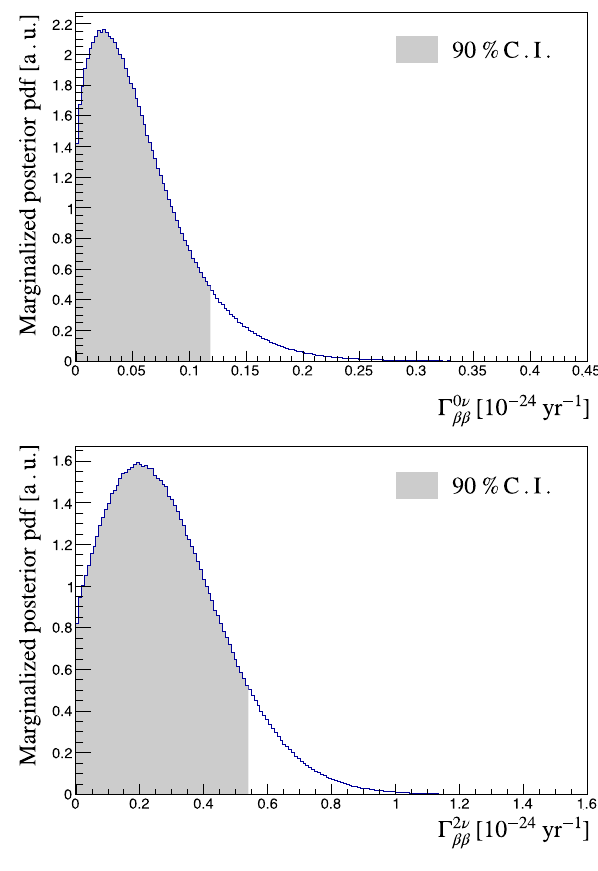
Fig. 4 Marginalized decay rate posterior pdf for 0 νββ (top) and 2 νββ (bottom) from the combined fit with all systematics. We show the 90% C.I. in gray